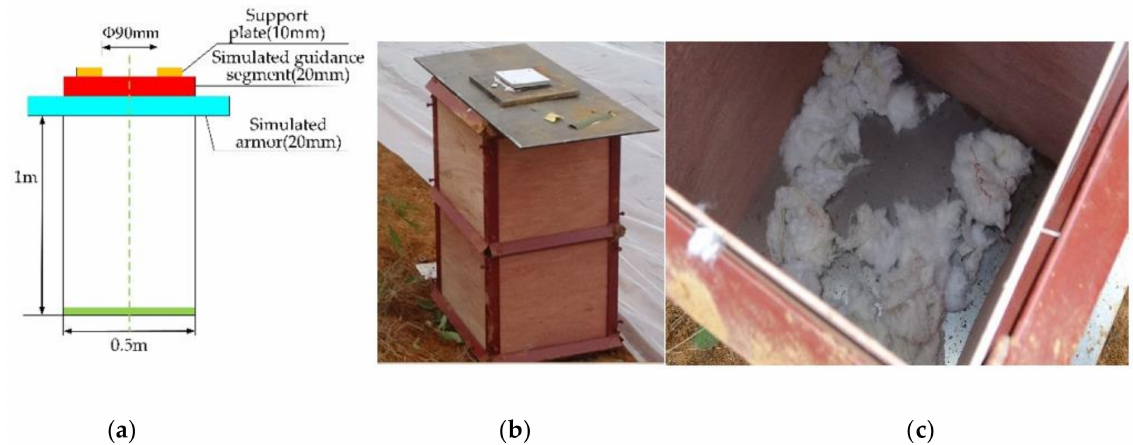
Figure 8. Layout of the test device. ( a ) The schematic diagram of the experimental device; ( b ) The test chamber; and ( c ) The cotton yarn in the test chamber.